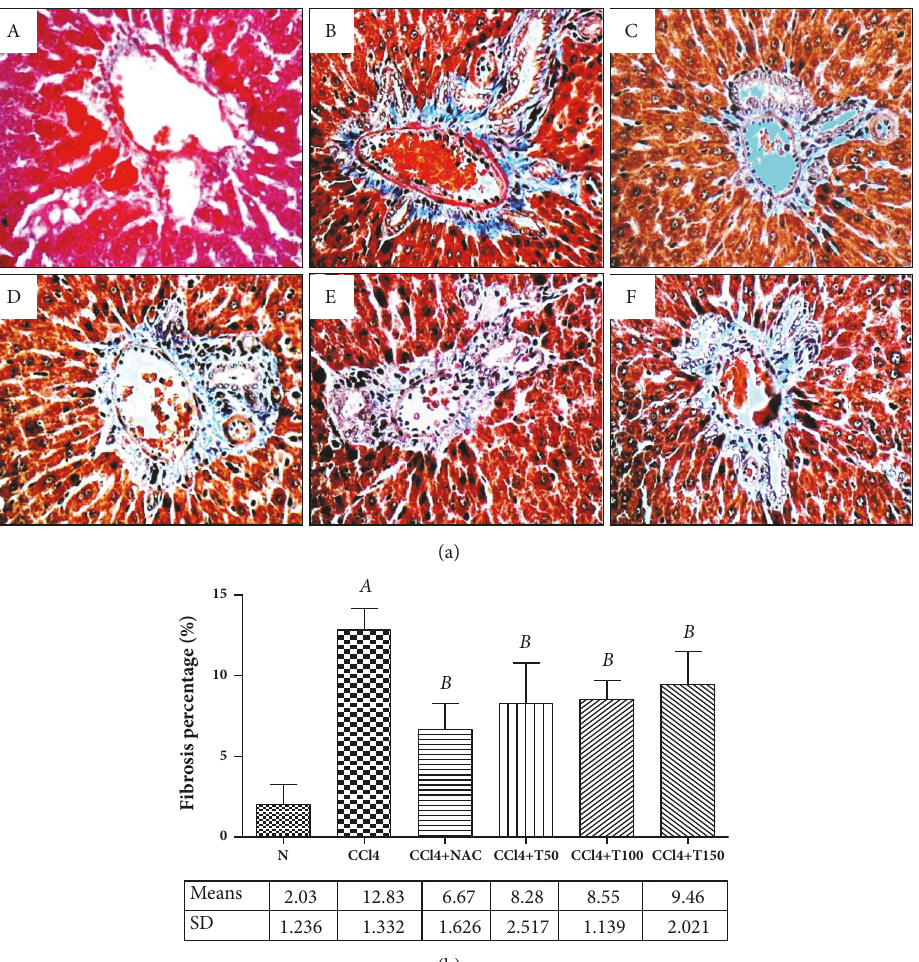
Figure 2: (a) The liver histopathological examination samples stained by Masson’s trichrome (400x). Blue color showed collagen deposition around portal triad. A: normal group. B: CCl 4 group. C: CCl 4 +NAC group. D: CCl 4 +T50 group. E: CCl 4 +T100 group. F: CCl 4 +T150 group. N: normal, CCl 4 : carbon tetrachloride, NAC: N-acetylcysteine150 mg/kg body weight/day, and T50, T100, and T150: DLBS Proliverenol 50, 100, and 150 mg/kg body weight/day. (b) Fibrosis percentage of normal control, CCl 4 , CCl 4+ NAC150, CCl 4+ T50, CCl 4+ T100, and CCl 4+ T150 groups. Data represent the means ± SD (n=5). N: normal, CCl 4 : carbon tetrachloride, NAC: N-acetylcysteine 150 mg/kg body weight/day, and T50, T100, and T150: Proliverenol 50, 100, and 150 mg/kg body weight/day. A = p < 0.05 vs. N, B = p < 0.05 vs. CCl 4 ( 𝛼